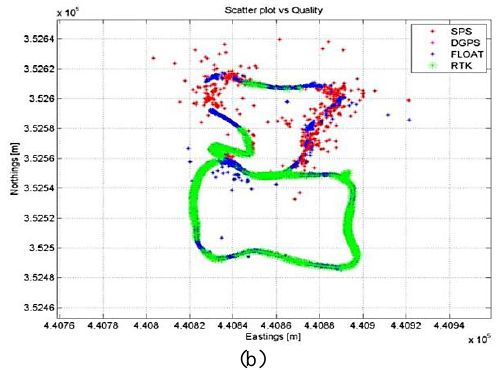
Figure 1. Mobile Kinematic Results: (a) Javad Mobile Kinematic 3D; (b) Javad Mobile Kinematic 2D.